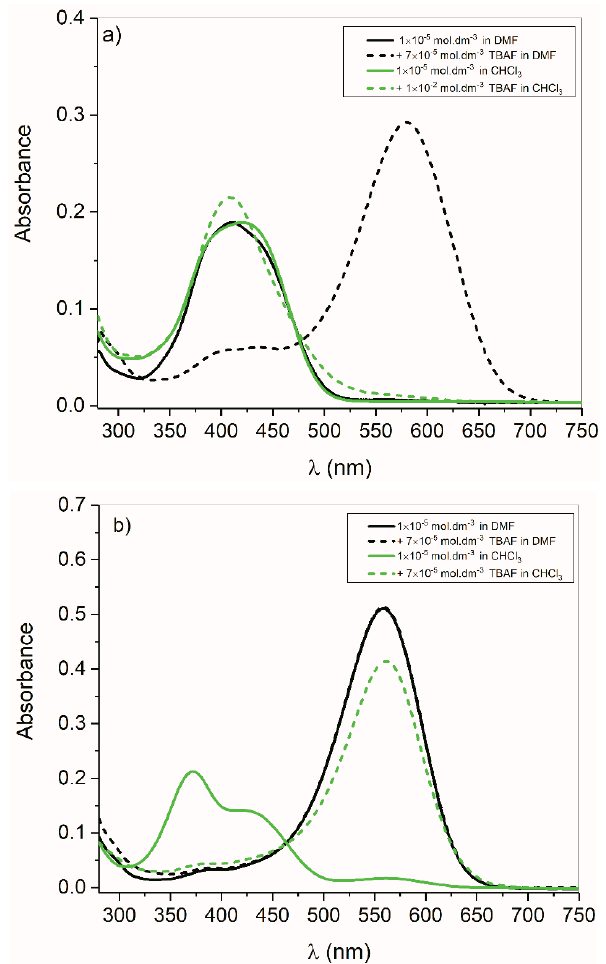
Figure 8. Solvent e ff ect (DMF, CHCl 3 ) on the formation of compounds 4 anions of E- and Z- isomers in Figure 8. Solvent effect (DMF, CHCl 3 ) on the formation of compounds 4 anions of E- and Z- isomers the presence of TBAF: ( a ) 3 E ; ( b ) 3 Z in the presence of TBAF: ( a ) 3 E ; ( b ) 3 Z . Table 3. Z anion formation rate constants k Z anion [s − 1 ] and Z anion = E anion thermal isomerization rate